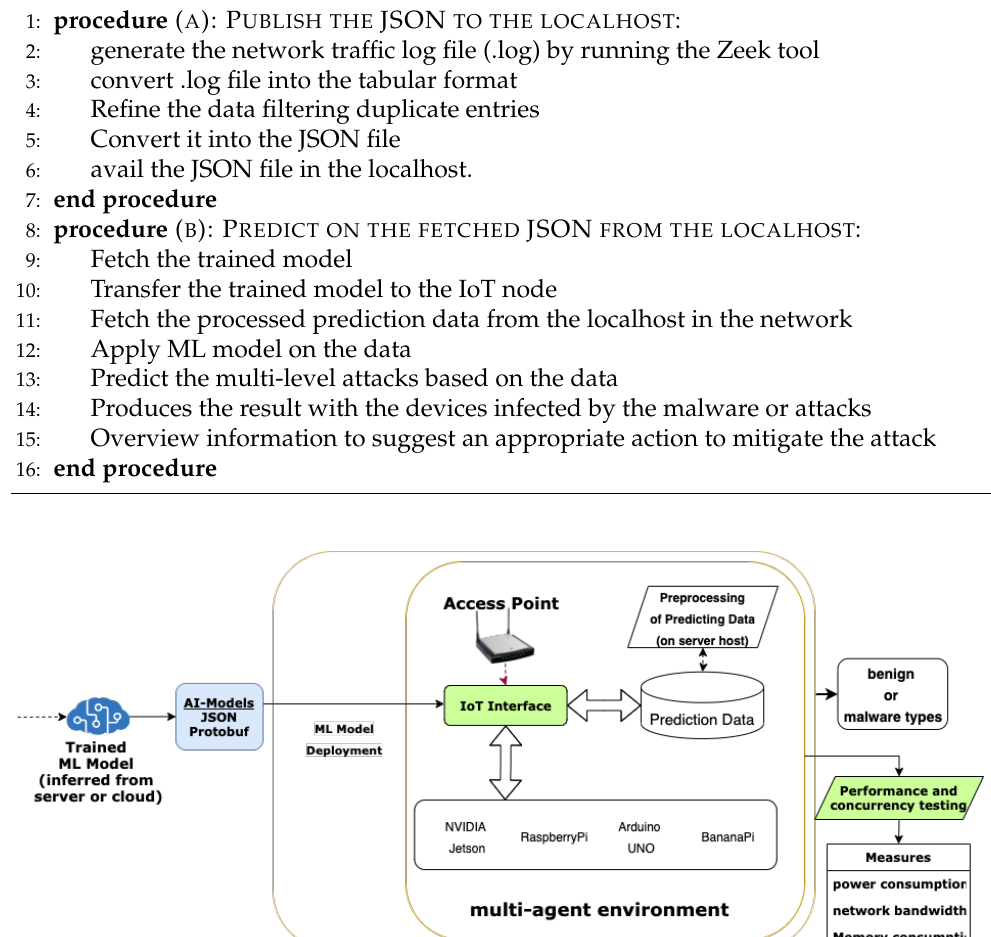
Algorithm 1 AI-enabled model transfer approach.